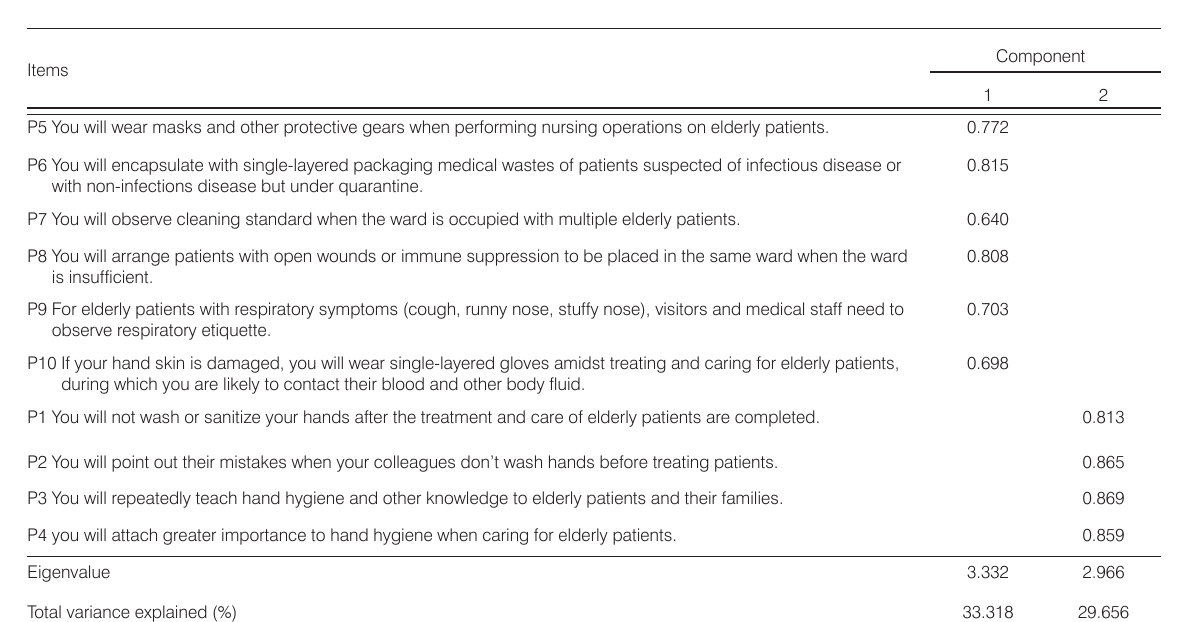
Table 5. Component matrix* of attitude.